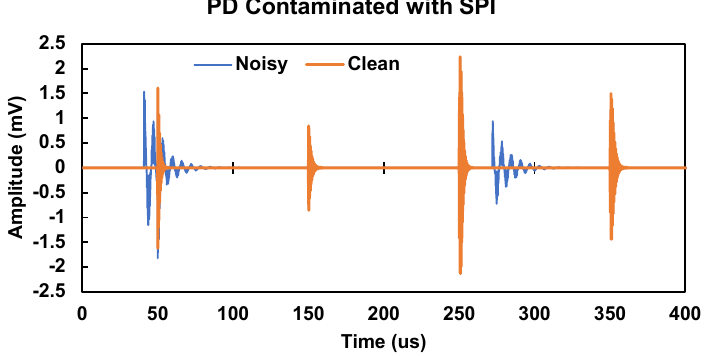
Figure 22. Sample of the simulated PD signal contaminated with SPI noise. Signal SNR = 3.4 dB and NCC = 0.73.